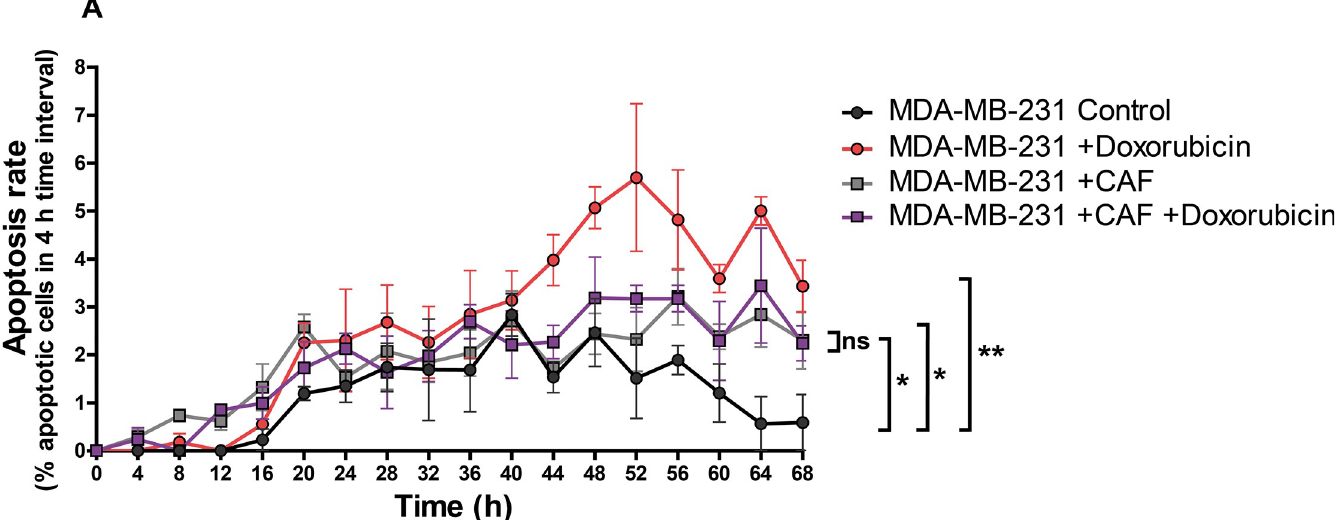
Fig 5. Cancer-associated fibroblasts promote chemo-resistance in breast-cancer-on-chip. MDA-MB-231 cancer cells were co-cultured on-chip +/- cancer-associated fibroblasts (CAFs) and +/- doxorubicin (1 μ M) treatment. Final CAF:cancer ratio was 1:6. The graph shows the time-course quantifications of the apoptosis rate, calculated in 4 h-time-intervals ( T LAG = 4 h), for a total duration of 68 h. The graphs show the means of 3 measurements on 3 view fields from the same experiment (+/- SEM). The data illustrating the MDA-MB-231 without CAF conditions come from the same videos analyzed for Fig 2 but with different time-interval resolution. For statistical analysis, the measurements for each of the 4 conditions were assembled regardless of the time variable (n = 51 per condition). The different CAF/drug conditions were compared to the MDA-MB-231 control condition. The data passed the Shapiro-Wilk normality test, therefore the unpaired t test was applied. �� indicates p < 0.001, � indicates p < 0.05 and ns indicates not significant.